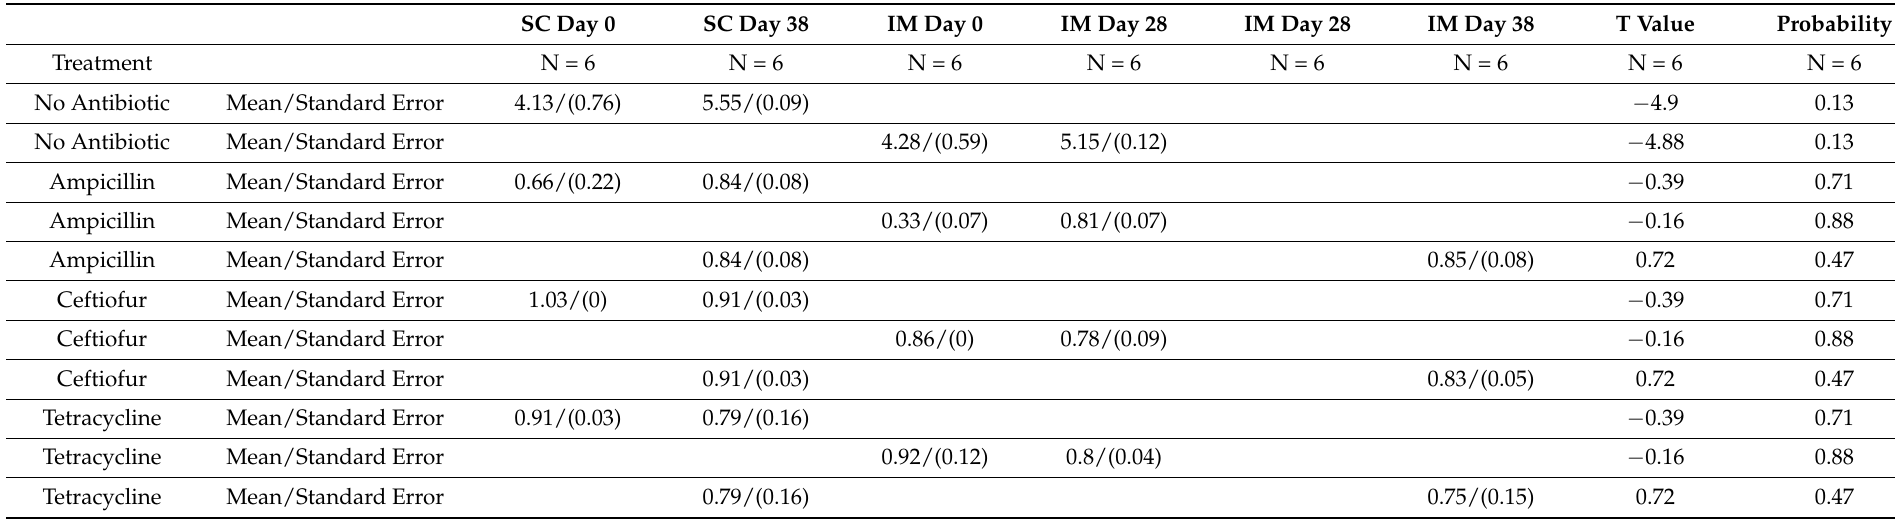
Table 4. Predetermined Student’s T tests to observe significant differences at particular time points for E. coli isolates grown with or without antibiotics. There were no significant differences noted for any of the above